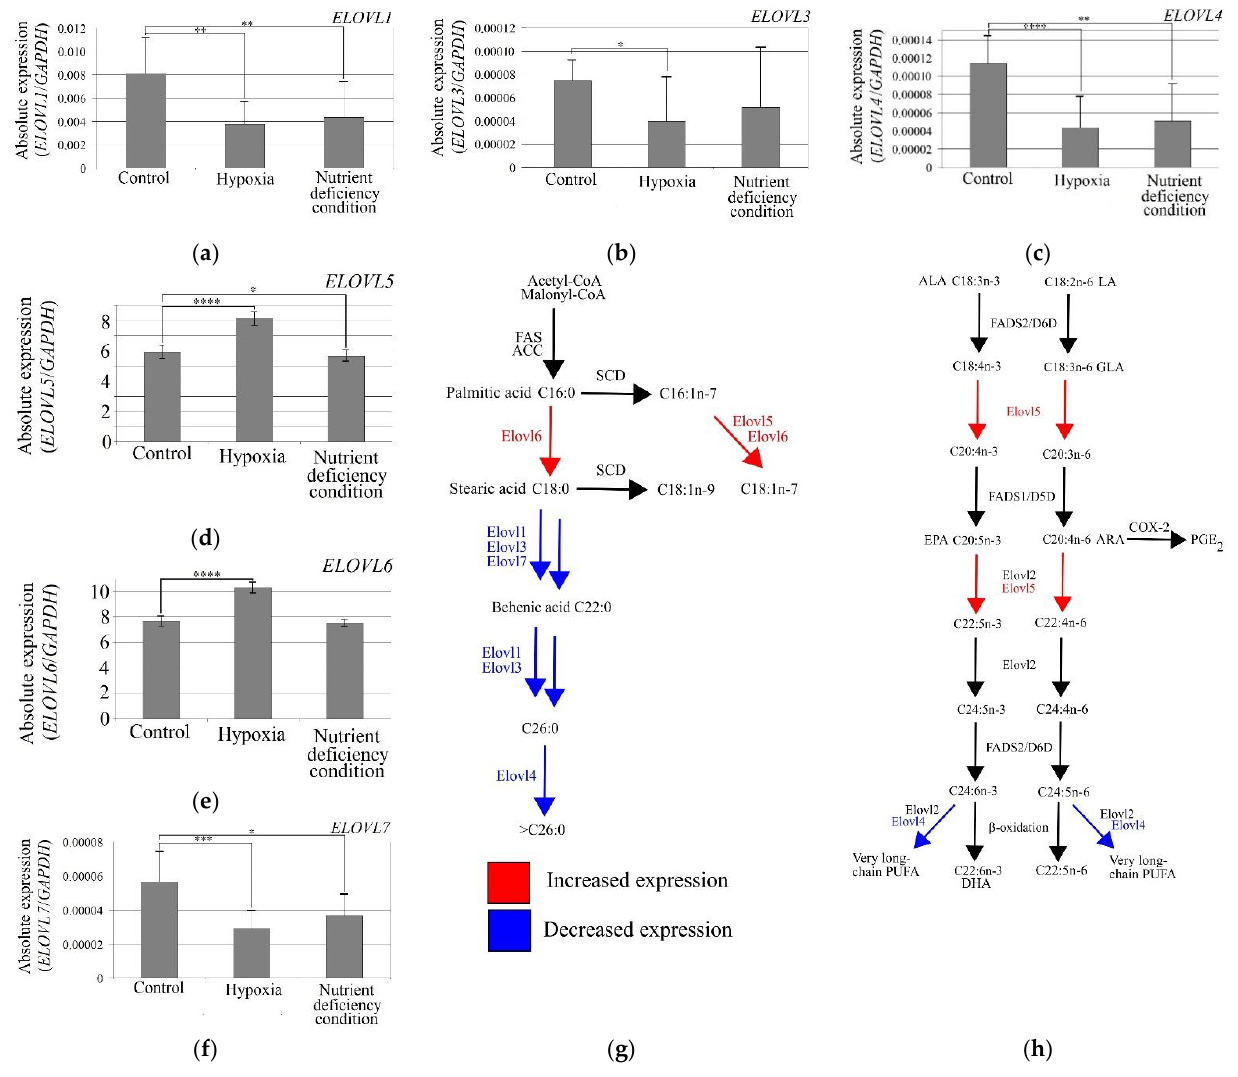
Figure 5. Effect of hypoxia and nutrient-deficient conditions on the expression of elongases. Effect of hypoxia and nutrient deficiency conditions on the expression of ( a ) ELOVL1 , ( b ) ELOVL3 , ( c ) ELOVL4 , ( d ) ELOVL5 , ( e ) ELOVL6 , ( f ) and ELOVL7 in U-87 MG cells. Hypoxia affects ( g ) the synthesis of MUFA and SFA and ( h ) PUFA. * — Statistically significant difference in the expression of a given elongase between controls estimated by Wilcoxon signed-rank test ( p < 0.05). ** — p < 0.01. *** — p < 0.001. **** — p < 0.0001. Nutrient-deficient conditions reduced the expression of ELOVL1 ( p = 0.0018), ELOVL4 ( p = 0.0018), and ELOVL7 ( p = 0.010) in the U-87 MG cells. Nutrient-deficient